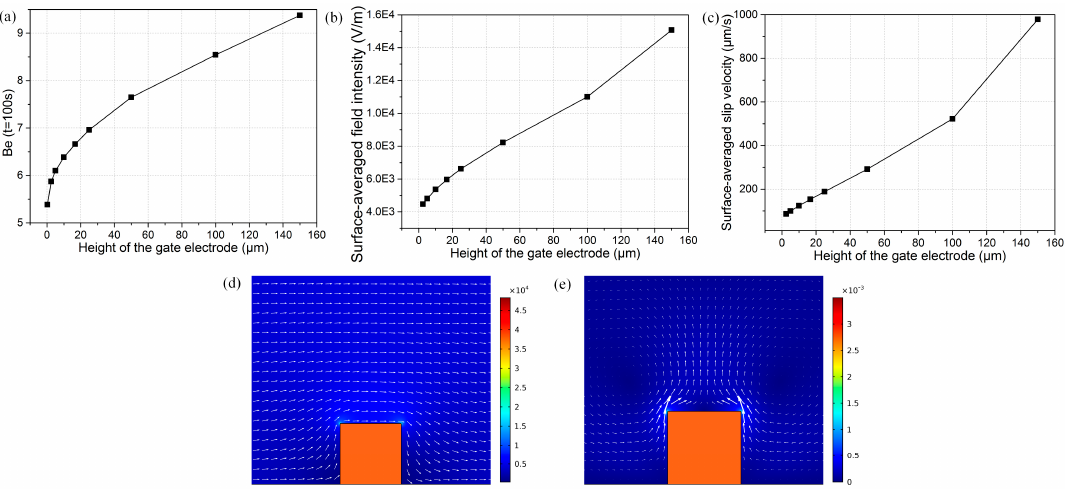
Figure 8. At f = 10 Hz and V 1 = 4 V, plot of: ( a ) bound antigen enhancement vs. height of gate electrode; ( b ) surface-averaged field intensity predicted at different gate electrode heights; ( c ) height-dependent surface-averaged ICEO velocityies on top of the bipolar electrode; ( d ) and ( e ) surface and arrow plots around the surface of floating electrode: ( d ) electric field distribution around the bipolar metal strip; ( e ) ICEO fluid flow field around metal surface.